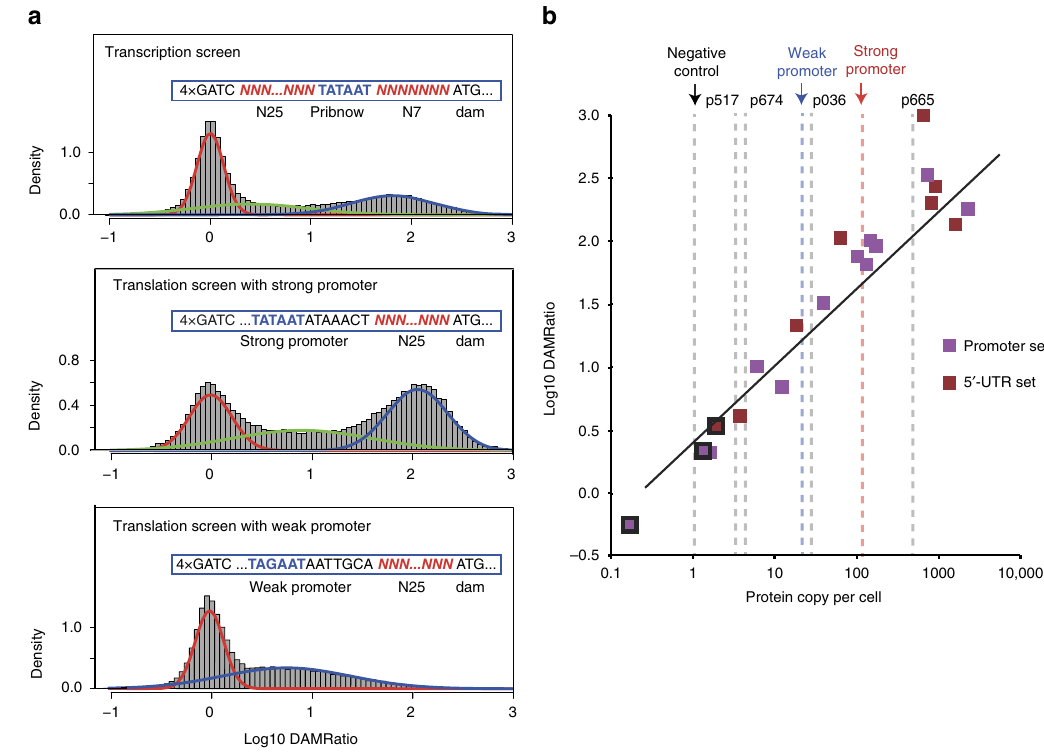
Fig. 2 Cassette design for screening three different libraries and the relationship between Dam copy number and DAMRatio. a Design of the promoter and 5 ′ -UTR constructs and their observed DAMRatio distributions. The transcription screen had a total of 82,639 promoter sequences, while the translation screen had 94,945 and 71,478 5 ′ -UTR sequences for the strong and weak promoters, respectively. The sequence details of the constructs are shown inside the blue box . Randomized sequence positions are indicated by Ns and the numbers below the blue boxes indicate how many random positions are included. In all cases, four GATC sites are located upstream of the promoter regions. To compare the log-transformed DAMRatios among different experiments, we standardized them by setting the left-most peak to zero. The fi tted Gaussian mixture distributions are indicated as red , green , and blue lines (see Methods). The blue and red lines indicate the probability of being highly and lowly productive sequences, respectively. b Relationship between DAMRatio and Dam protein copy number. Twelve different promoter sequences and eight 5 ′ -UTR sequences were selected from the different random libraries based on their DAMRatios to cover a broad range of Dam activities. The protein copy numbers of four natural promoters (p517, p674, p036, and p665; see Methods) and strong and weak promoters are depicted as dashed lines . Dam protein copy numbers were estimated with regression models generated by published proteome-wide copy number data 30 and mass spectrometry data. The squares outlined in black represent clones that were not detected by mass spectrometry. Their protein copy numbers were estimated from the DAMRatio using linear interpolation and were not used in the correlation analysis. The overall Pearson ’ s correlation coef fi cient ( r ) between protein copy number and the DAMRatio is